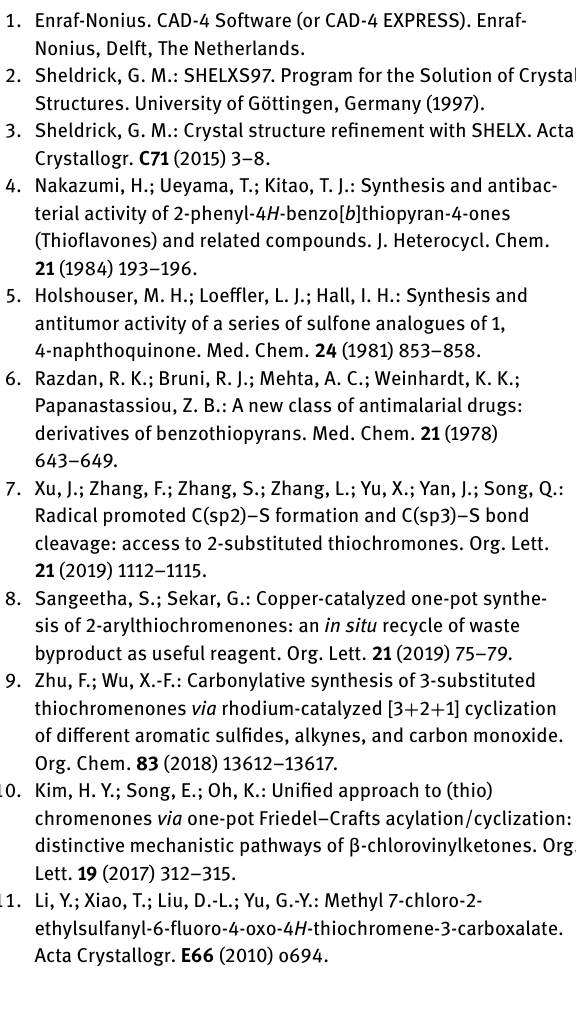
figure. The crystal belongs to the monoclinic system crystal- lizing in the space group P 2 1 / n . The structure shows that the benzo moiety and the six-membered sulfur heterocycle in the molecule are almost in the same plane. Bond lengths and angles are in the expected ranges